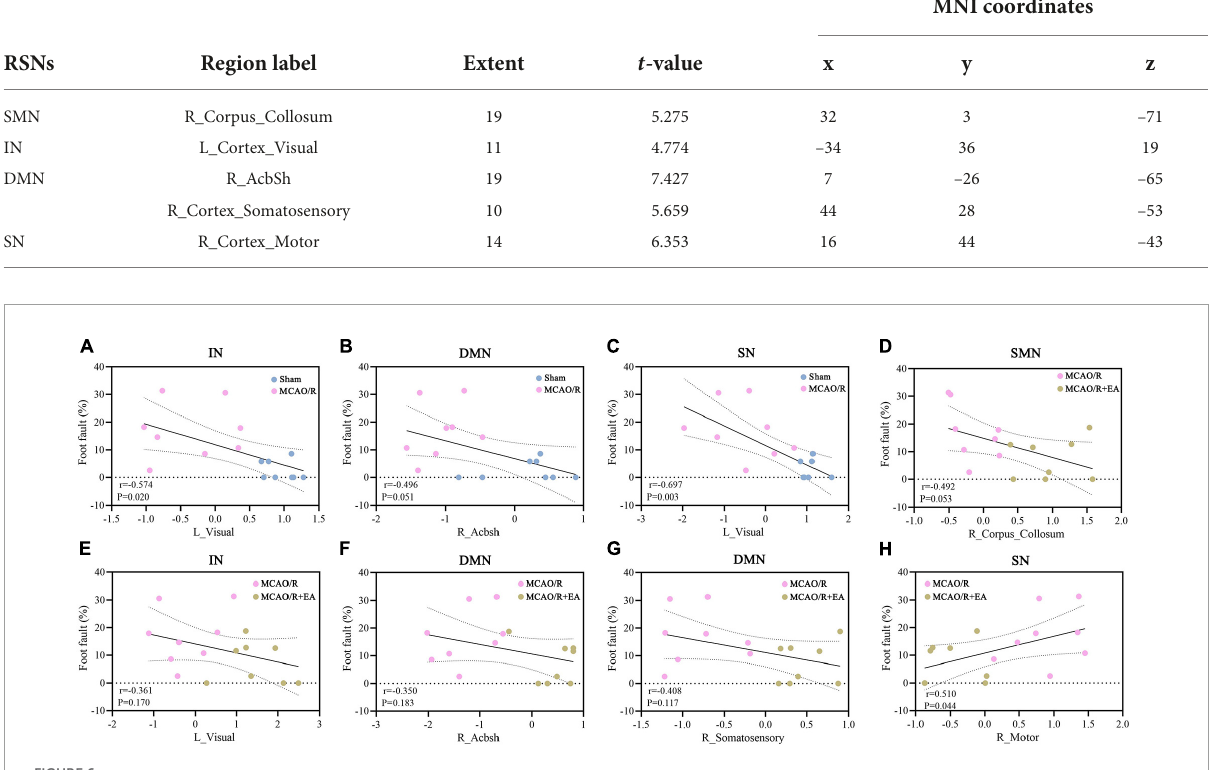
FIGURE6 Correlation analyses demonstrate the link between behavior and brain area functional activations. (A–C) In the sham group and MCAO/R group, the behavioral results showed a significant negative correlation with the left visual cortex in the IN (A) and SN (C) networks. The rate of foot faults did not correlate (positive or negative) with the right AcbSh in the DMN (B) . (D–H) In the MCAO/R group and MCAO/R + EA group, there was a significant positive correlation between the rate of foot faults and right motor cortex area in the SN network (H) . The foot fault rate was not correlated (positive or negative) with the right corpus callosum in the DMN (D) , the left visual cortex in the IN (E) , or the right AcbSh in the